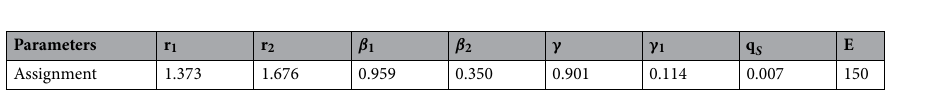
Table 2. Estimated results of epidemic parameters in Beijing